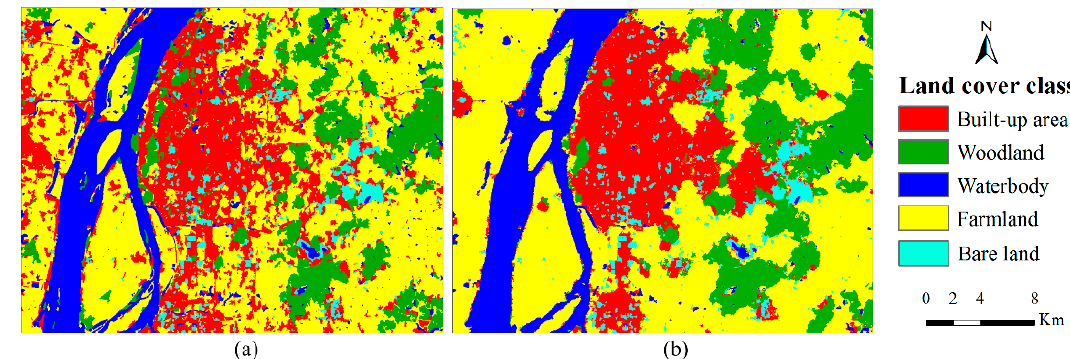
10 of 16 Figure 6. Land use/cover classification results for the Yinchuan study area: ( a ) pre-classification map; ( b ) MCRF post-classification. 4.3. Case 3 Results for Case 3 are provided in Figure 7 and Table 5. There are some residues of iron mines existing in the Maanshan city, which were classified as bare land. It is difficult to distinguish this kind of bare land from built-up area in this study area. That is why the pre-classification map has a relatively low producer’s accuracy for bare land (58%). Before post-classification, some bare land pixels were misclassified as built up area. After post-processing by the SS-coMCRF model, some misclassified bare land pixels were corrected. In the pre-classification map, because of spectral overlap of farmland with built-up area and woodland in the remotely sensed image, some pixels of built-up area and woodland were misclassified as farmland and similarly some pixels of farmland were misclassified as built-up area and woodland, thus resulting in relatively low producer’s accuracies (e.g., 63% for woodland and 70% for farmland). Because some waterbody areas were covered by water plants or other vegetation and those pixels were misclassified as farmland or woodland, the producer’s accuracy of waterbody was 85%. The MCRF post-classification operation